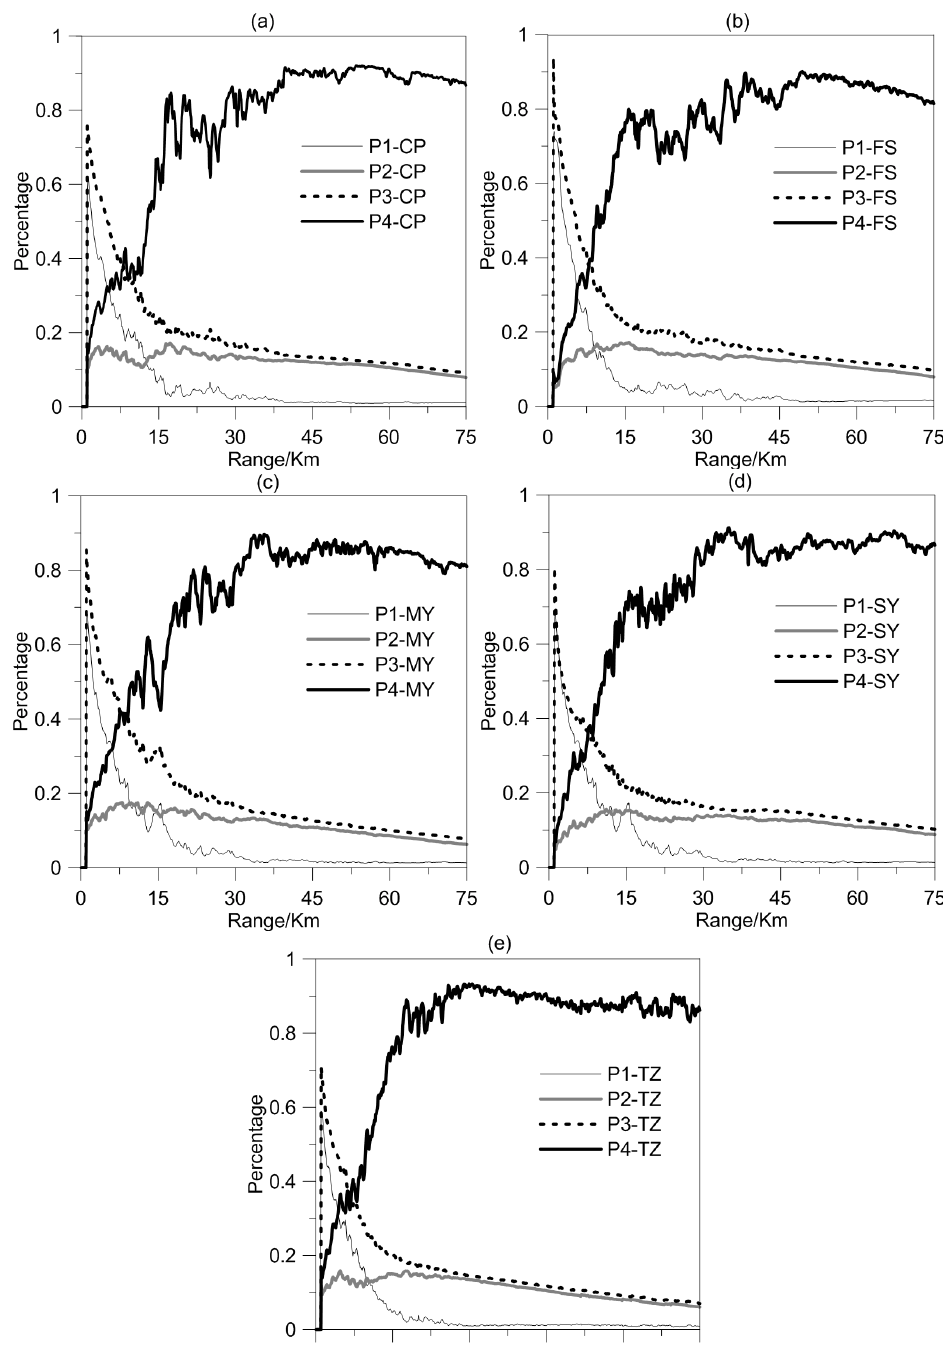
Figure 9. The occurrence frequency of azimuthal averaging of four statistics (dBP CAT , dBP ME , dBP Z , and dBP MEZ ) over 360 azimuths versus range for ( a ) CP, ( b ) FS, ( c ) MY, ( d ) SY, and ( e ) TZ radars, respectively.